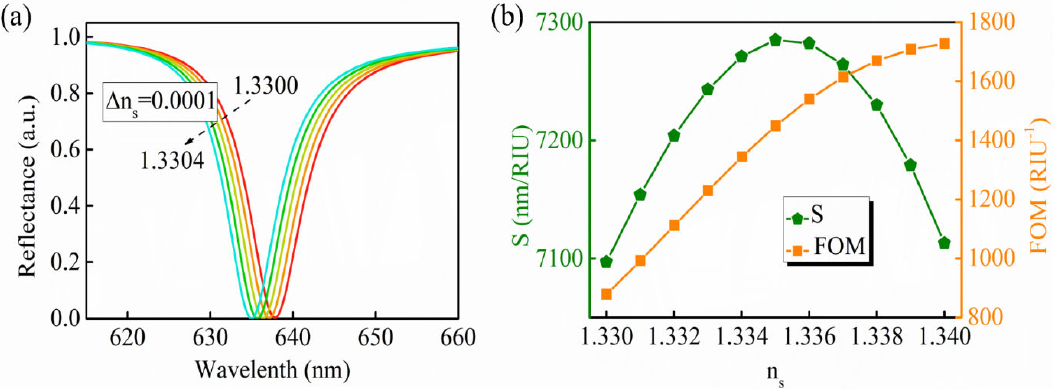
Figure 7. ( a ) The variation of the resonance signal with respect to the wavelength when the n s ranged from 1.33 to 1.3304 ( Δ n s = 0.0001). ( b ) The spectral sensitivity ( S = Δλ / Δ n s ) and the corresponding FOM of the proposed GW − LRSPR based on silicon. Note: the incident angle was fixed at 51.12°.